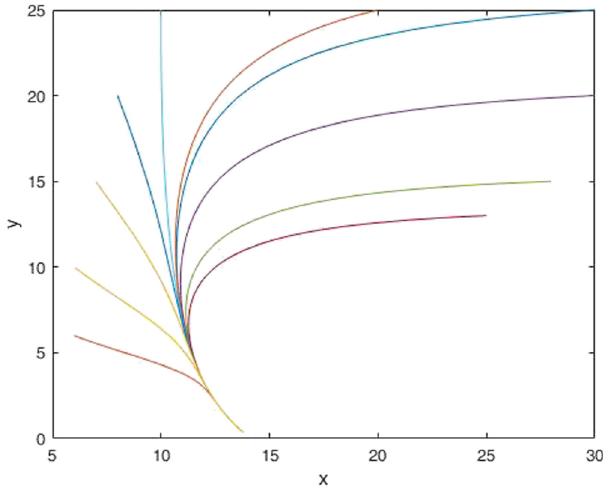
Figure 3: Stability of the boundary equilibrium.